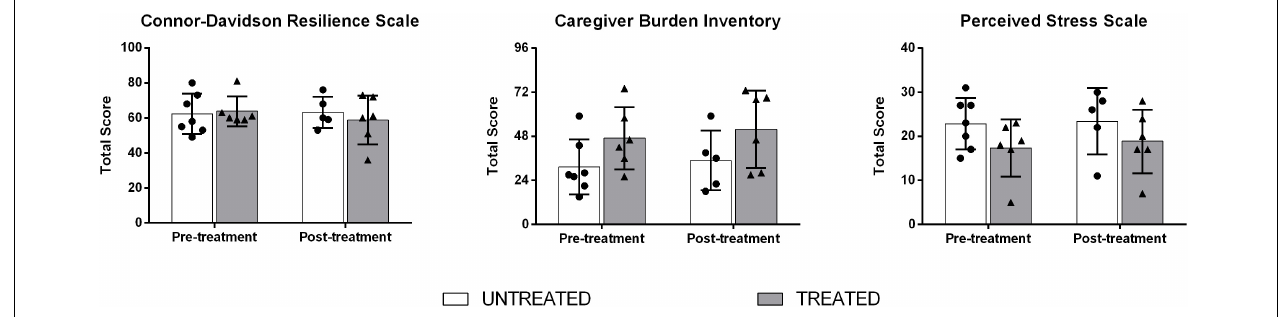
FIGURE 2 | Between-group comparison on Connor-Davidson Resilience Scale (CD-RISC), Caregiver Burden Inventory (CBI), and Perceived Stress Scale (PSS) scores at pre- and post-treatment.